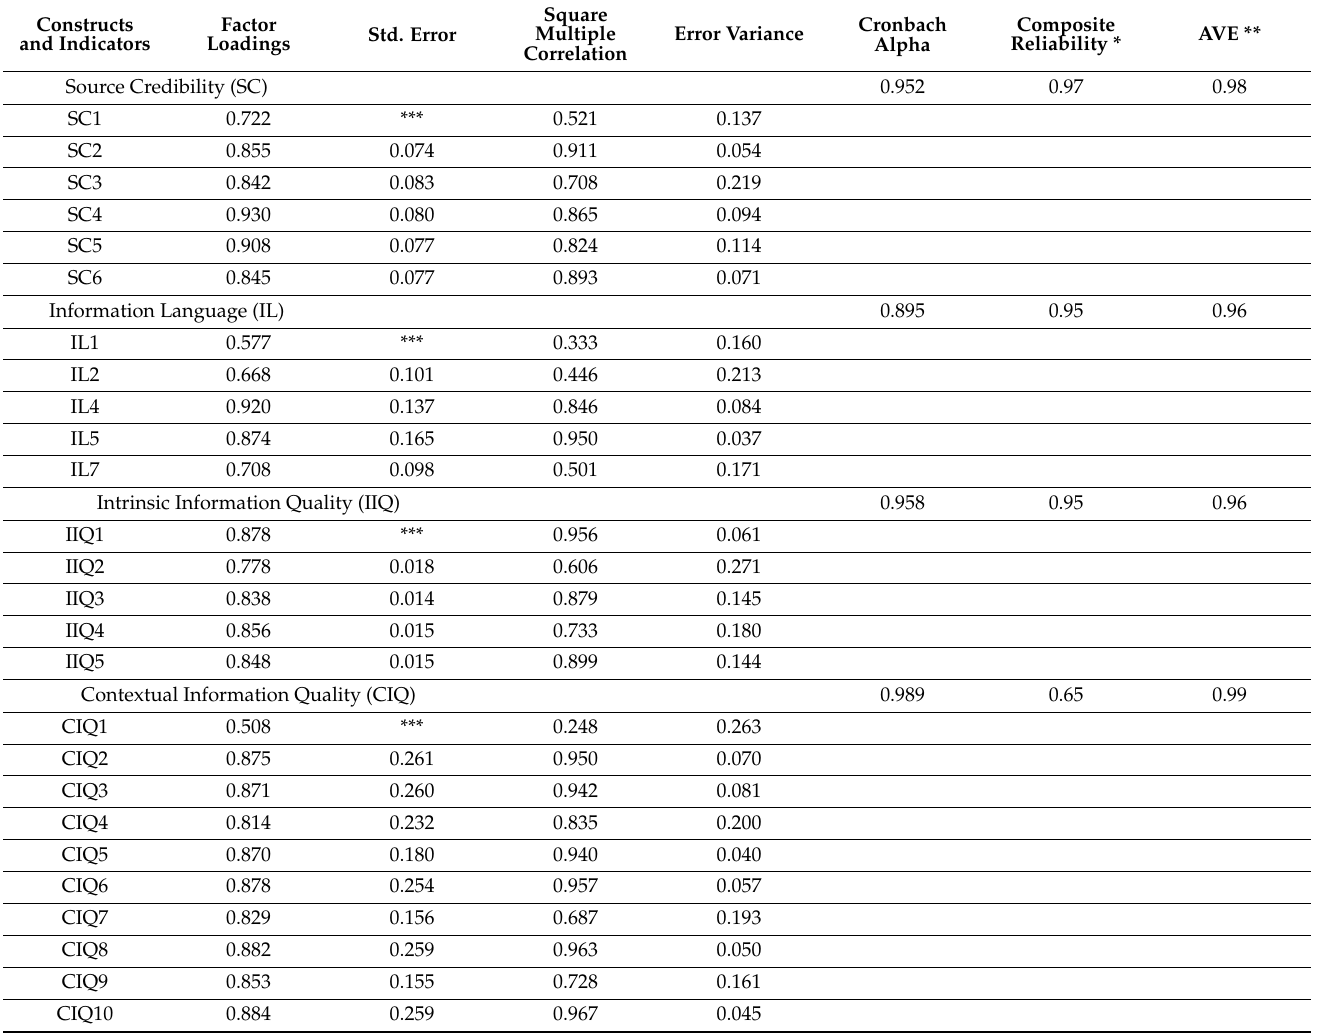
Table 5. Properties of the final measurement